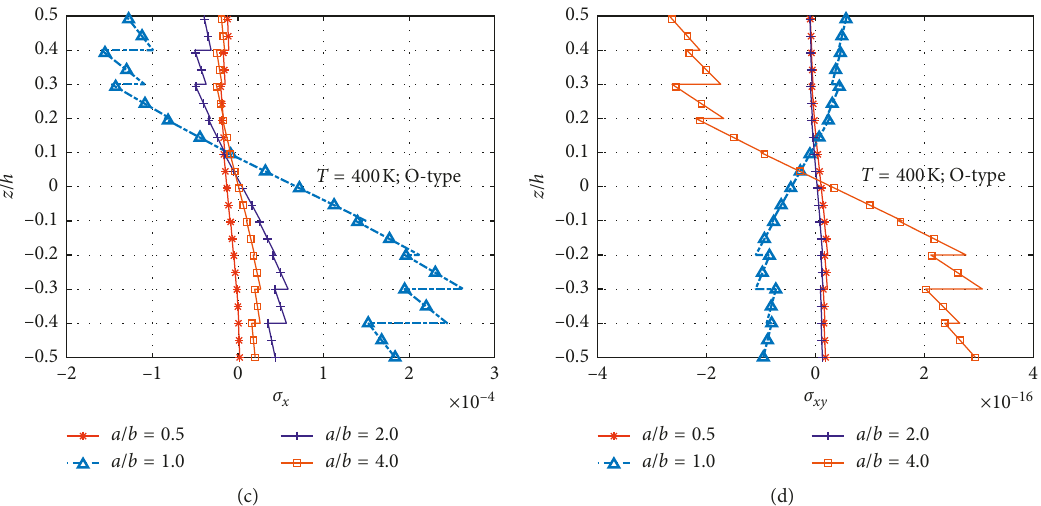
Figure 10: Influence of length-to-width ratio on nondimensional deflection, velocity, and stress of the center point at T ; (b) velocity v ; (c) stress σ x ; (d) stress σ xy shell: (a) deflection w ∗ ∗ Table 7: Influence of length-to-width ratio on the nondimensional deflection and velocity of the center point. a / b 0.5 1.0 2.0 4.0 Maximum value UD-type X-type 0.1186 Temperature T 400K (cid:31) UD-type